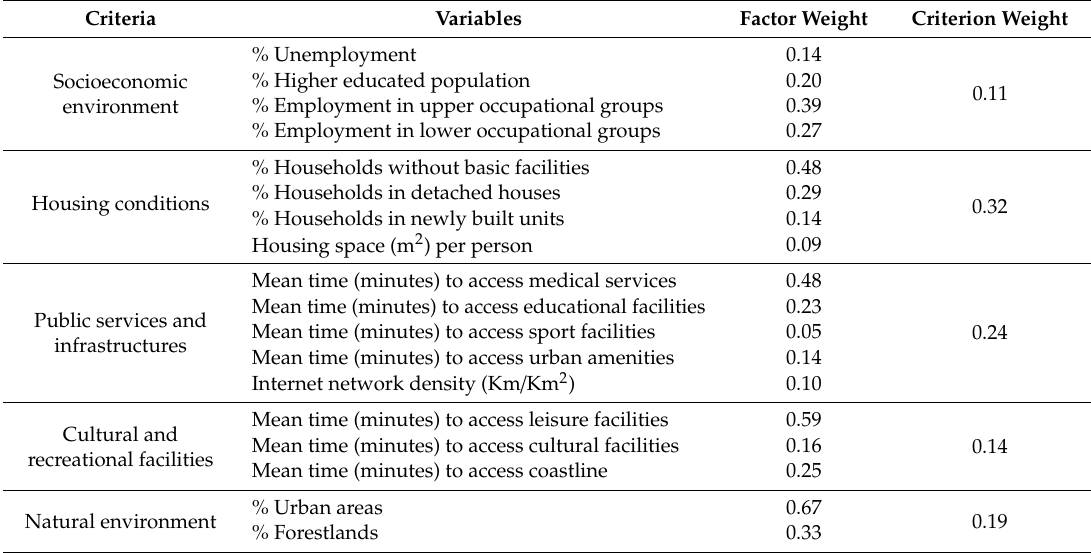
Table 4. Weights of variables derived from the analytical hierarchy process